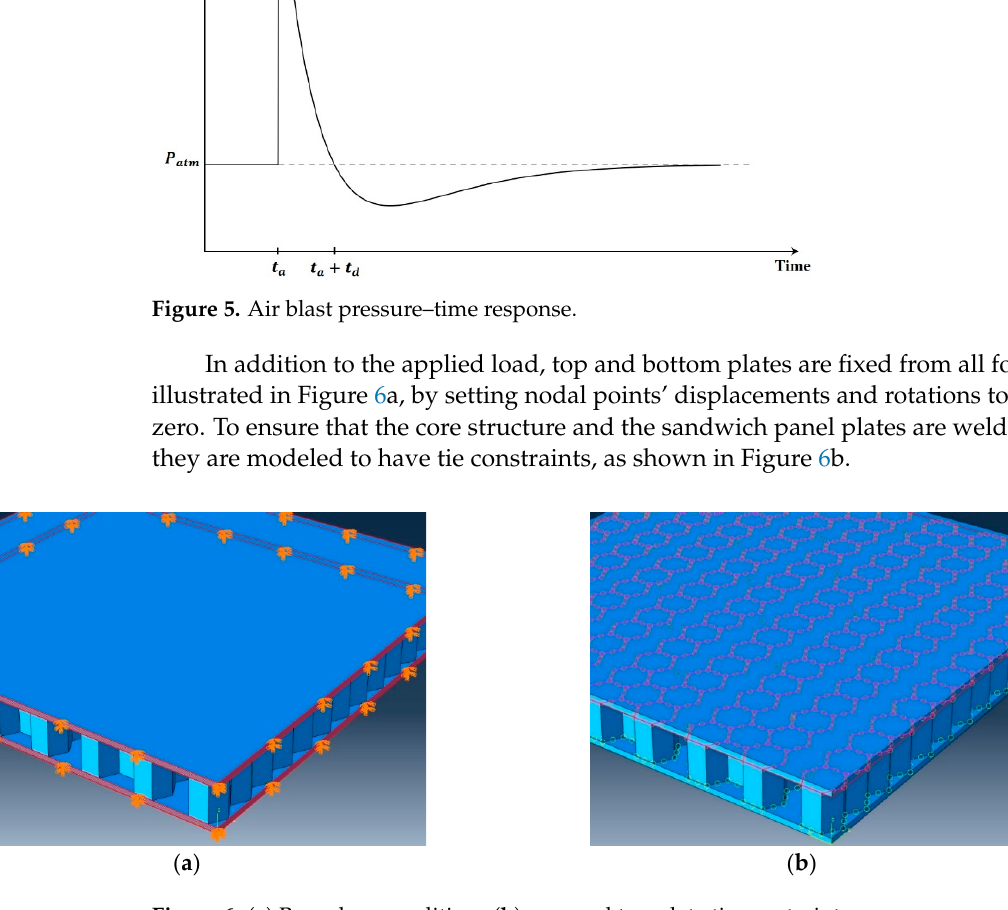
( b ) Figure 7. Displacement of ( a ) top plate, ( b ) bottom plate.